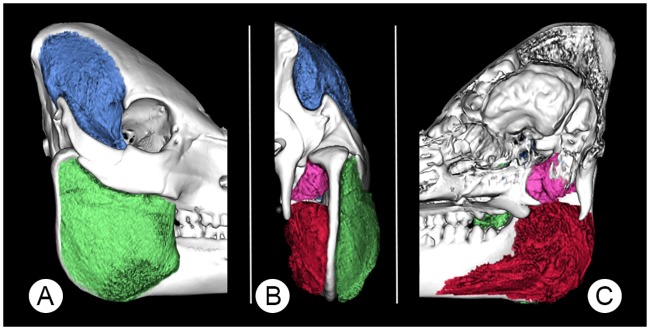
A 3D-rendered skull of a 12 months-old Göttingen Minipig showing the segmented masticatory muscles.Where (A) is a lateral, (B) a posterior and (C) a medial view. Pictured are the masseter (green), temporal (blue), medial pterygoid (red) and lateral pterygoid (pink) muscles.